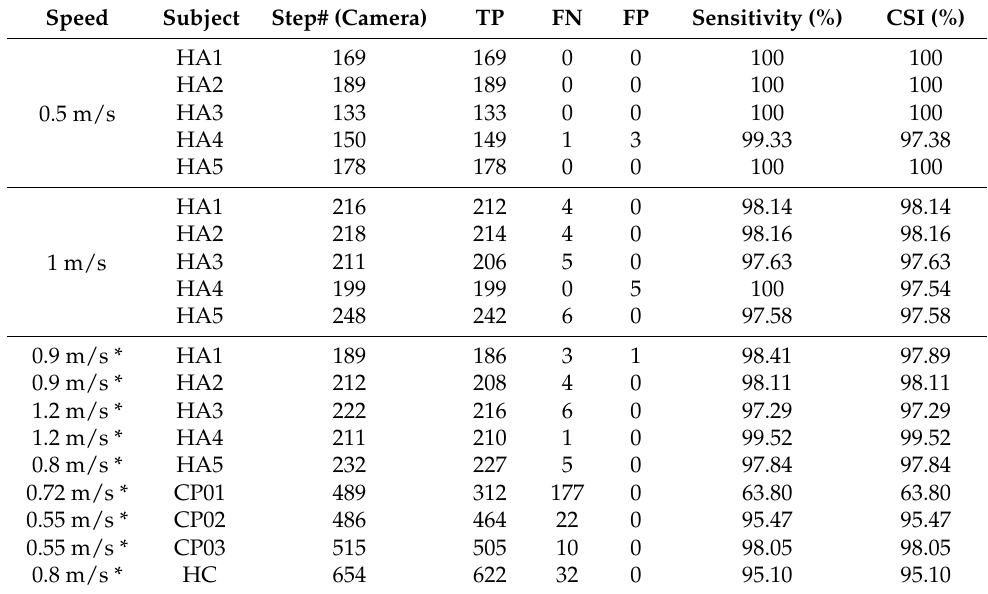
Table 1. Phidget performance in five healthy adults (HA) at three different treadmill speeds in three children with unilateral CP and one healthy child (HC). * preferred speed.